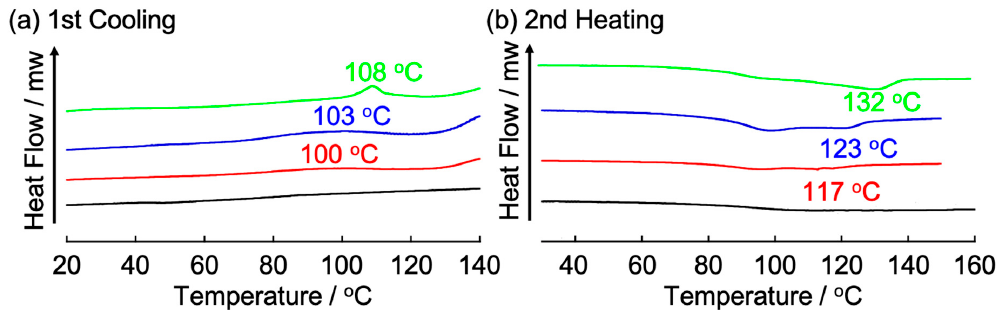
Figure 3. Polarized optical microscopic (POM) observations 1 and complexes of 1 with benzenesulphonic acid (BSA) for 1 12100 , 1 1210 , 1 125 , 1 122 , and 1 121 . All scale bars indicate 100 μ m. A, P, and S indicate analyzer, polarizer, and sheared direction, respectively. 1 12100 , 1 1210 , 1 125 , 1 122 , and 1 121 indicate 1 : BSA = 100:1, 10:1, 5:1, 2:1, and 1:1 (in molar), respectively.